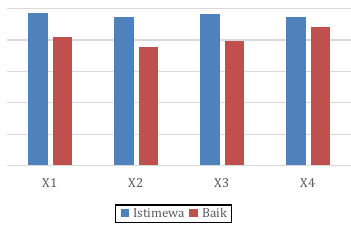
Figure 6. The chart bar of Belawan port centroid